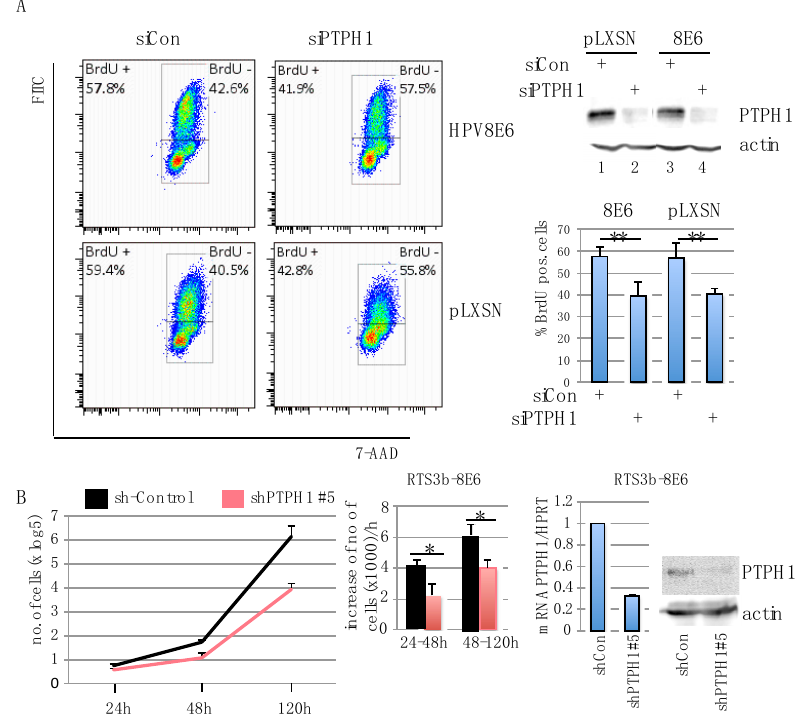
Figure 3. PTPH1 supports proliferation of keratinocytes. ( A ) HaCaT-pLXSN and HaCaT-HPV8E6 cells were transfected with siRNA against PTPH1 or control and used for a BrdU assay. The efficiency of the knock down of PTPH1 was confirmed by Western blot (Lanes 1–4). The graph represents the mean values of BrdU positive cells in % of three independent experiments (** p < 0.01) ( B ) RTS3b-E6 cells were transfected with pGIPZ-sh-control or pGIPZ-shPTPH1#5, neomycin and puromycin resistant cells were pooled. RNA and protein extracts were prepared to demonstrate the efficiency of the knock down by RT-PCR and Western blot. 5 × 10 4 cells were seeded in triplicate in 6-well plates and the number of cells was counted at different time points (* p < 0.05).